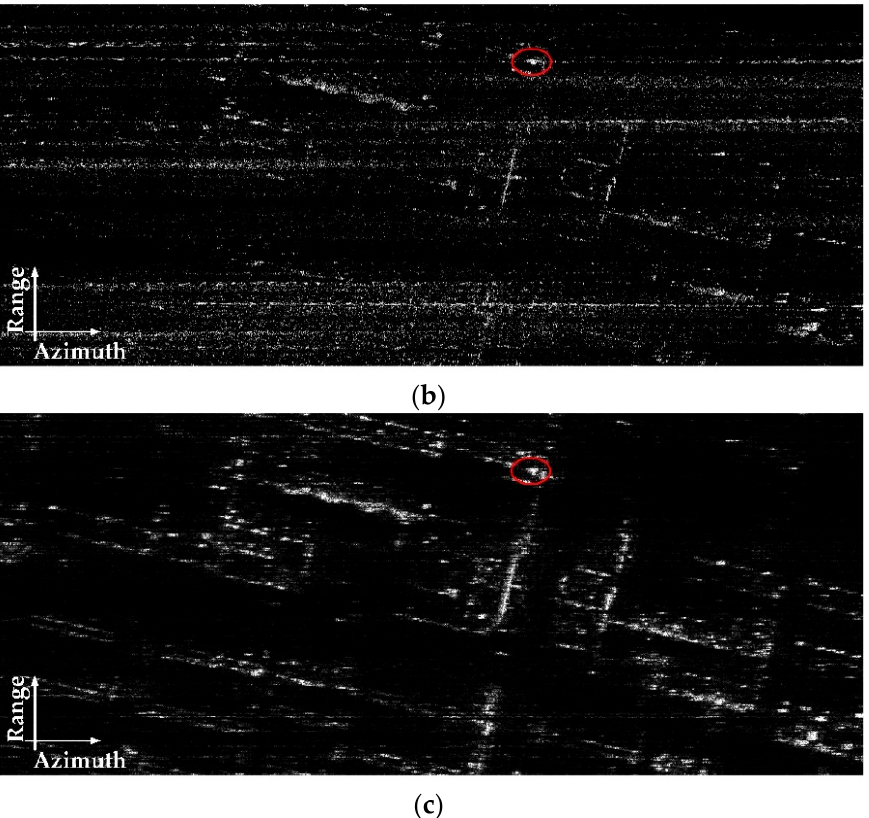
Figure 14. Imaging results of real airborne SAR data. ( a ) Coarse observation of Sat-1. ( b ) Reconstruc- tion result of the L1 algorithm. ( c ) Reconstruction result of the proposed algorithm. Table 7. Evaluation